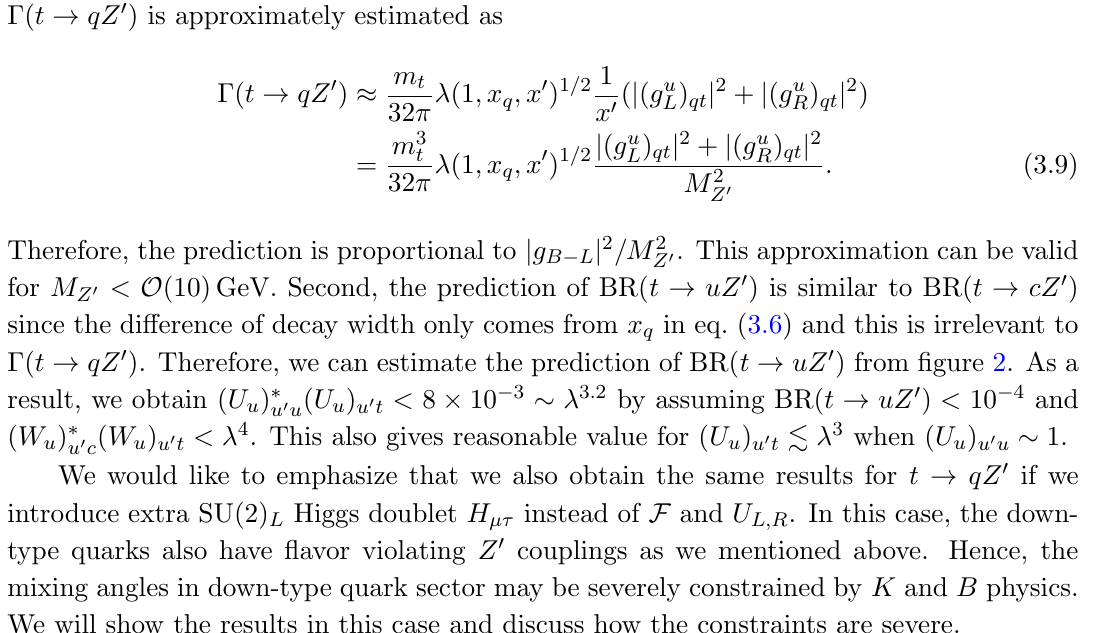
( U u ) u 0 t . The red solid, dashed u 0 c ( W u ) u 0 t = (cid:21) 4 , (cid:21) 5 and (cid:21) 6 with (cid:21) = 0 : 22, respectively. The u 0 c ( W u ) u 0 t = 0 u 0 c